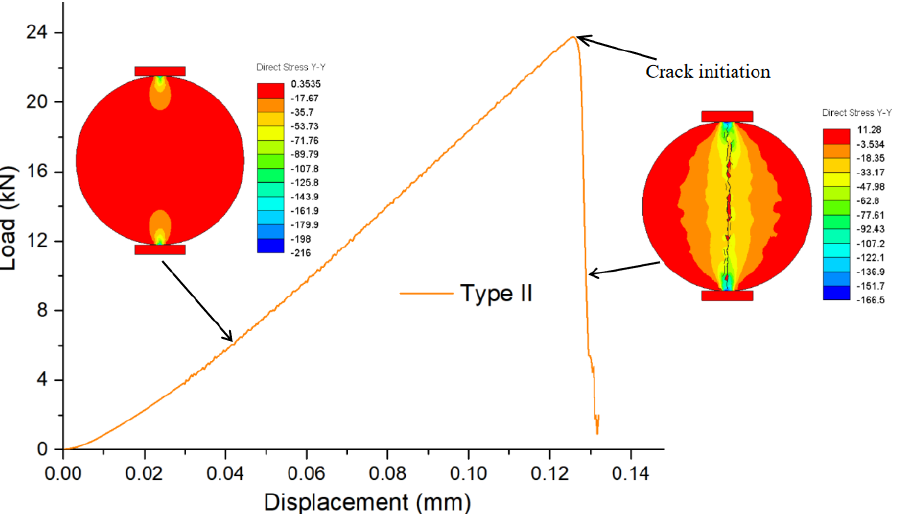
Figure 6. Load–displacement curves for the Type II Brazilian disc testing.